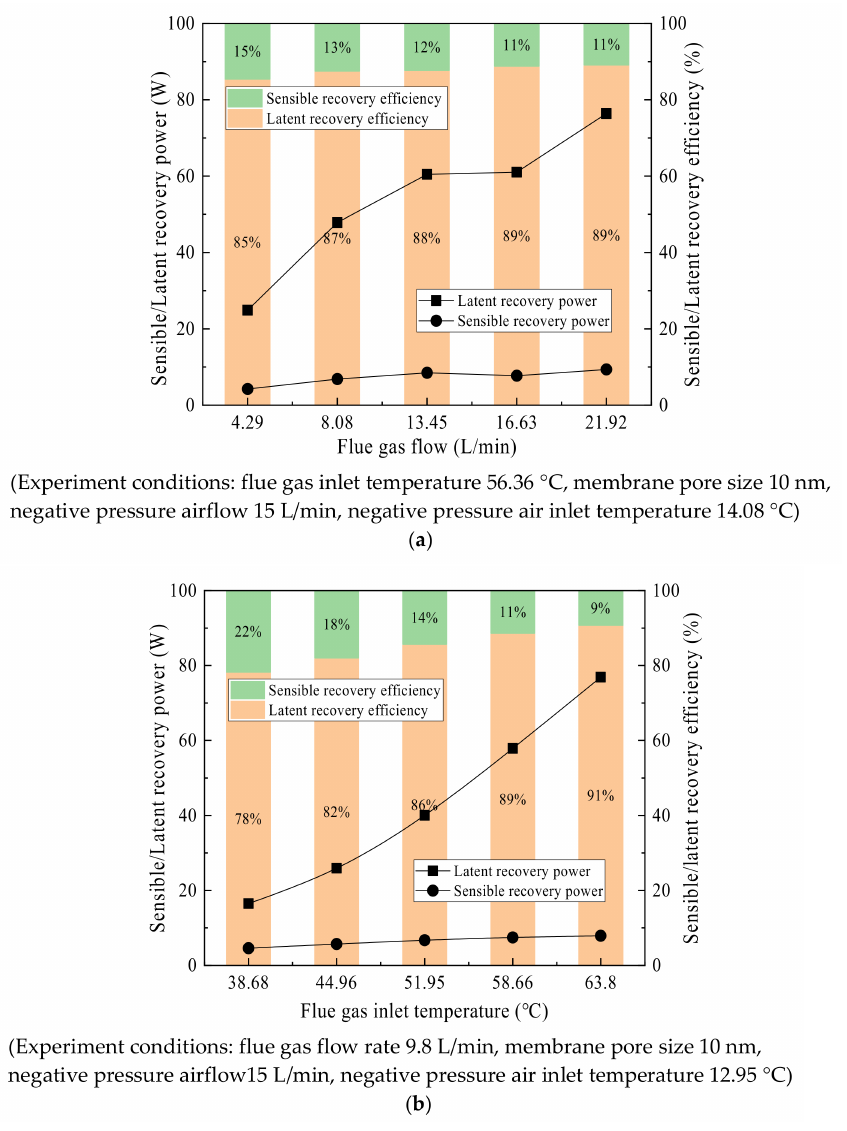
Figure 22. Sensible heat/latent heat recovery characteristics from flue gas. ( a ) Latent/sensible heat recovery power/proportion vs. Flue gas flow. ( b ) Latent/sensible heat recovery power/proportion vs. Flue gas inlet